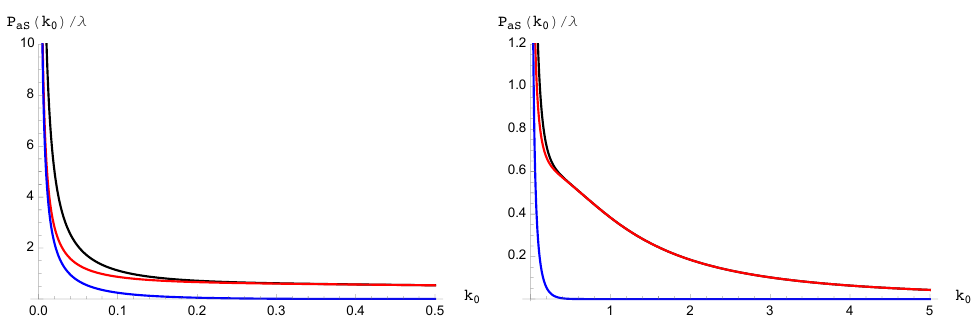
Figure 2 . The forward (red), backward (blue) and total (black) probabilities P aS ( k 0 ) of anti-Stokes scattering, with m = 1 .